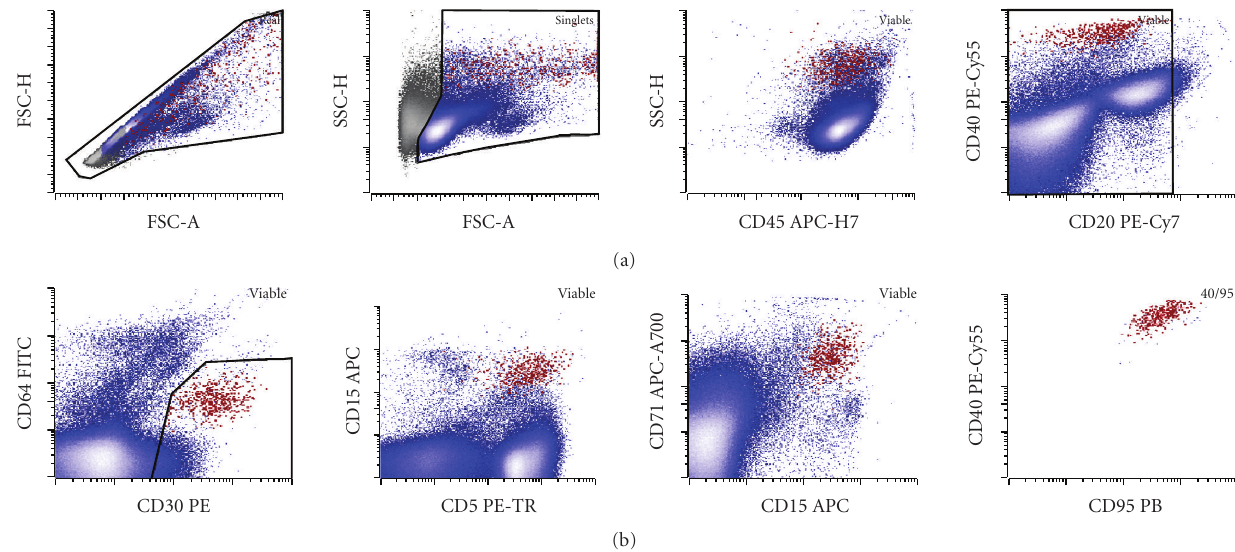
Figure 3: Identification of a small HRS population in a clinical sample: malignant HRS cells shown in red have increased forward scatter area (FSC-A) and height (FSC-H) (note a subpopulation with HRS cells with disproportionately increased FSC-A likely corresponding to a rosetted population) and increased side scatter height (SSC-H) compared to the rest of the node cellularity (blue). The population showed bimodal, but mostly bright, expression of CD45, low levels of a B cell-marker CD20, no significant expression of a monocyte-marker CD64 (mild increase in apparent CD64 expression is due to autofluorescence of the HRS cells, which was previously verified by isotype control, data not shown), bright CD30, mostly bright CD5 (with a noticeable nonrosetted CD5 low to negative population), bright CD15 at a level slightly lower than granulocytes, and bright CD71 (transferrin receptor) consistent with high metabolic activity. Finally, the population shows a tight cluster in multiple projections including CD95 (bright) versus CD40. In this case, the HRS population represented 0.09% of the total white cells in the lymph node. The case was morphologically confirmed as CHL-nodular sclerosis type.